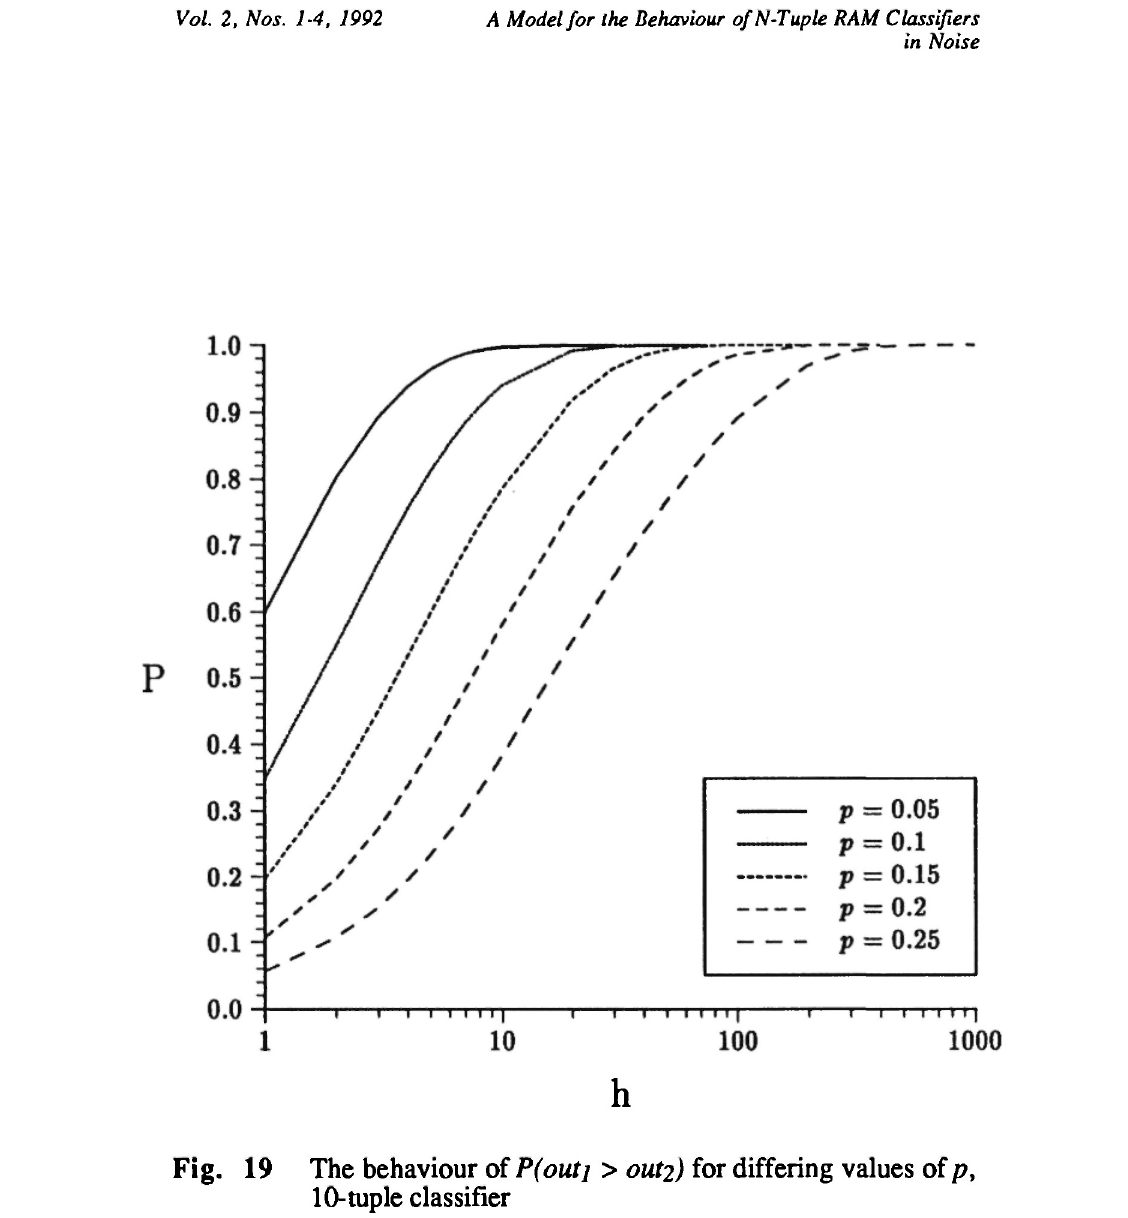
Fig. 19 The behaviour of P(outi > out2) for differing values of p, 10-tuple classifier